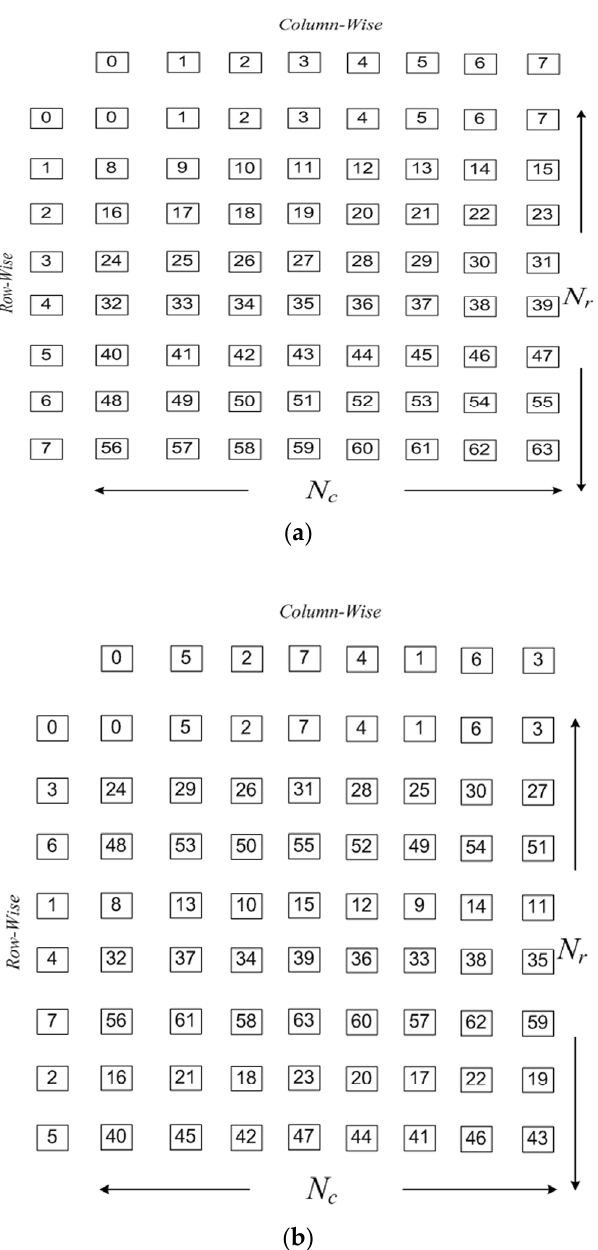
Figure 4. Arrangement of bits for an 8 × 8 channel ( a ) before interleaving and ( b ) after interleaving.